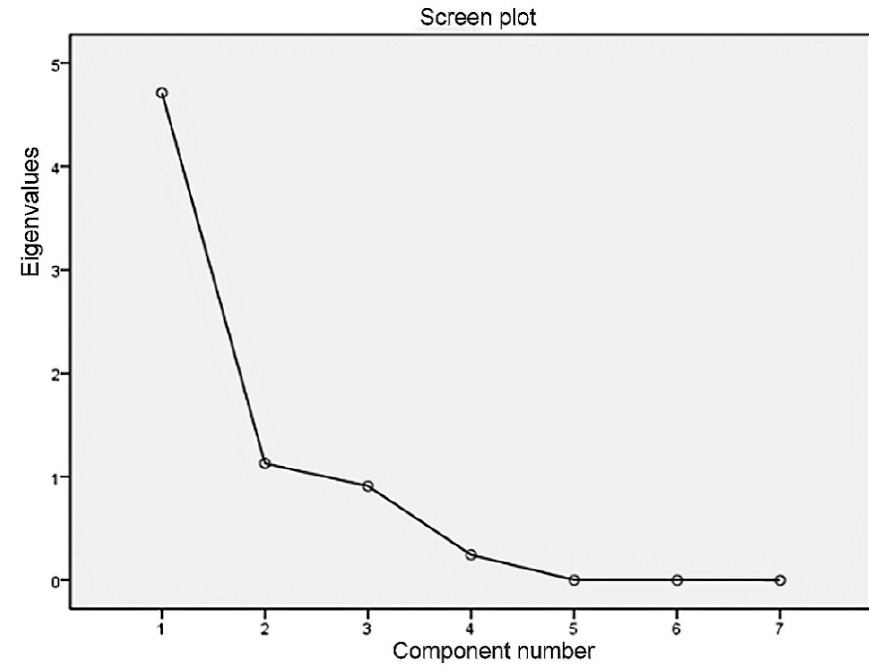
Figure 3. Scree plot.